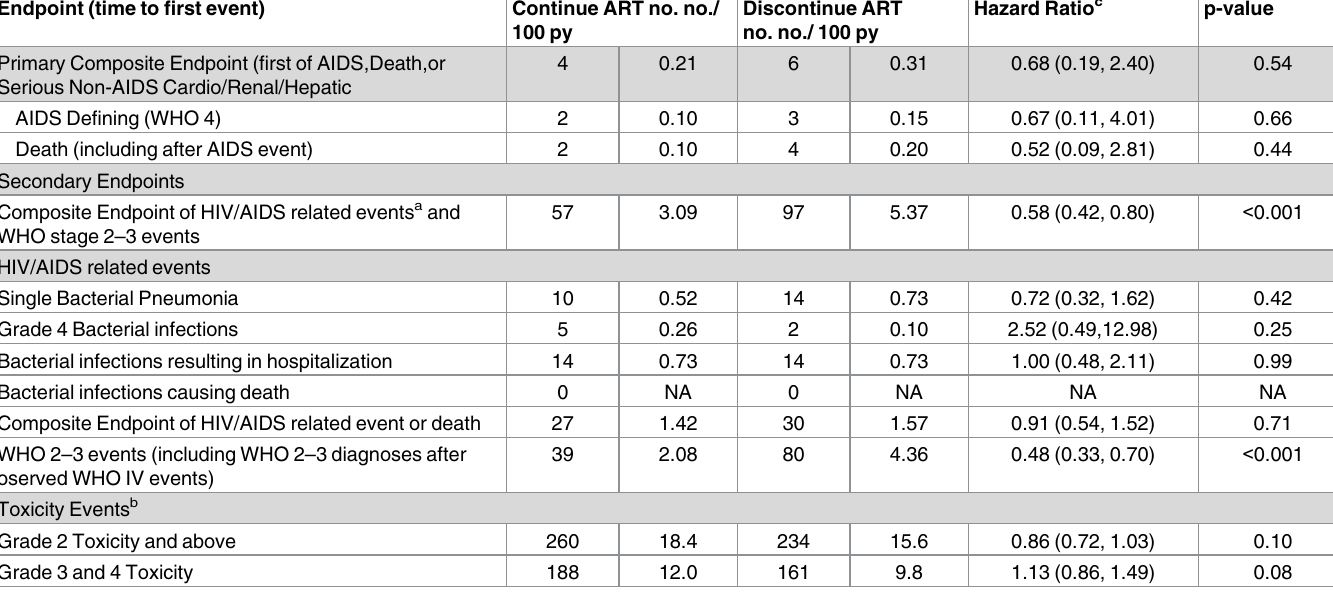
Table 3. Clinical